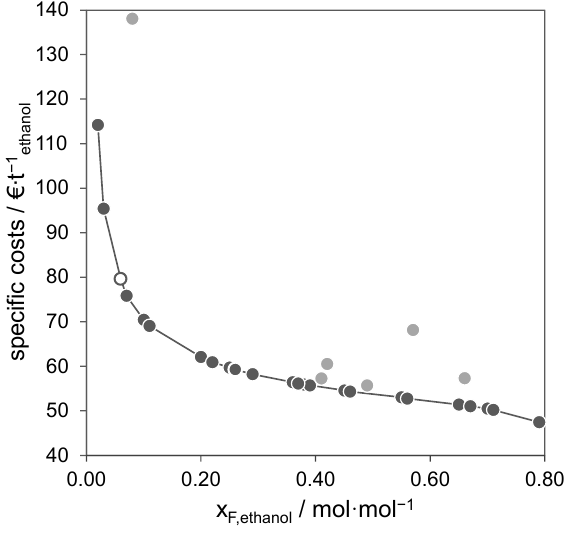
Figure 7. Specific costs of ethanol for variable feed compositions. The white circle indicates the feed composition from Sections 3.1.1 and